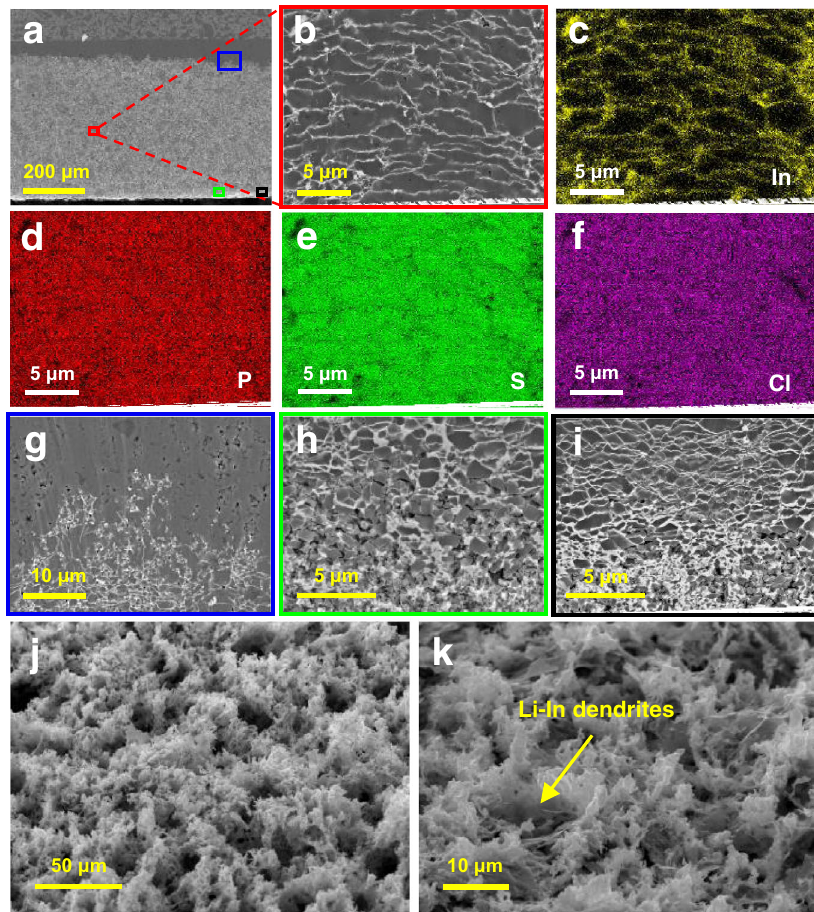
Fig. 3 SEM images of the Li-In|LPSCl|LNO@NCM622 cell after 897 cycles. a Cross-sectional SEM images of the cell. b SEM image and EDX mapping of c In, d P, e S, and f Cl in the middle region of Li-In dendrites. SEM images of Li-In dendrites g in the top region, h in the bottom region, and i in the transition region. SEM images of Li-In dendrites from an oblique view at j low magni fi cation and k high magni fi